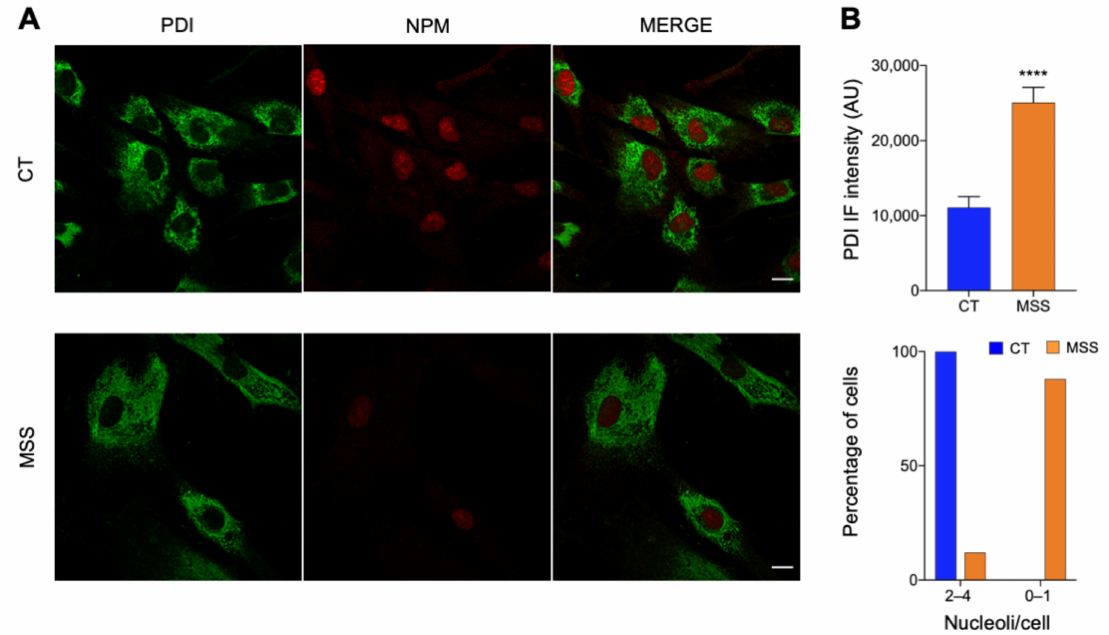
Figure 6. Fluorescence microscopy validation of proteomic analysis. ( A ) HF-CT (CT) and HF-MSS (MSS) were plated on glass coverslips, fixed in PFA 4%, and processed for immunofluorescence. Confocal images of cells stained for PDI (green) and NPM (red) are shown. The merge of green and red signal is also shown. Scale bar: 20 µ m. ( B ) Quantification of total PDI staining and the number of NPM-positive nucleoli/cell of the experiment shown in A. Blue and red bars indicate HF-CT and HF-MSS, respectively. **** p <